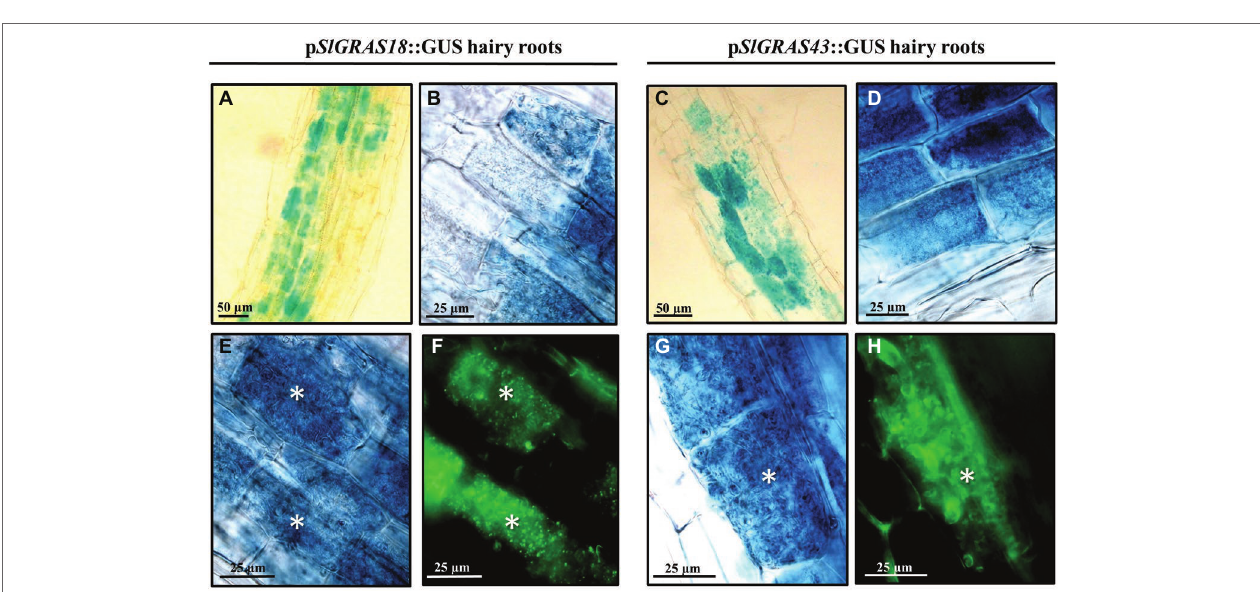
FIGURE 6 | Analysis of the SlGRAS18 and SlGRAS43 promoter activity in transgenic S. lycopersicum roots after GUS staining. GUS activity in A. rhizogenes - transformed roots expressing the p SlGRAS18 :GUS fusion (images on left) and the p SlGRAS43 ::GUS fusion (images on right) was assessed after 8 weeks of inoculation with R. irregularis . (A–D) GUS-stained whole roots. (E,G) GUS-stained and vibratome-sectioned roots. (F,H) Images corresponding to root sections from (E) and (G) , respectively, co-stained with WGA-Alexa Fluor 488, which labels the AM fungus and fluoresces green. White asterisks indicate arbuscules in the host cortical